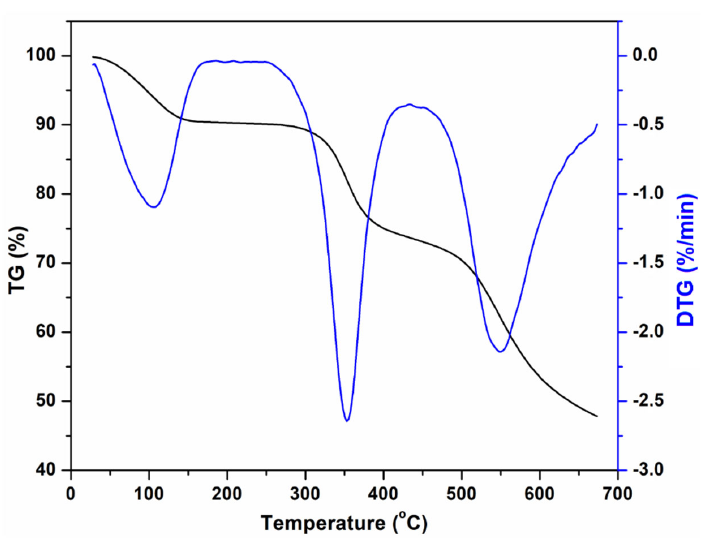
Figure 4. TG and DTG traces showing the influence of temperature on the behavior of the SPEEK polymer (TG—black line, DTG—blue line).